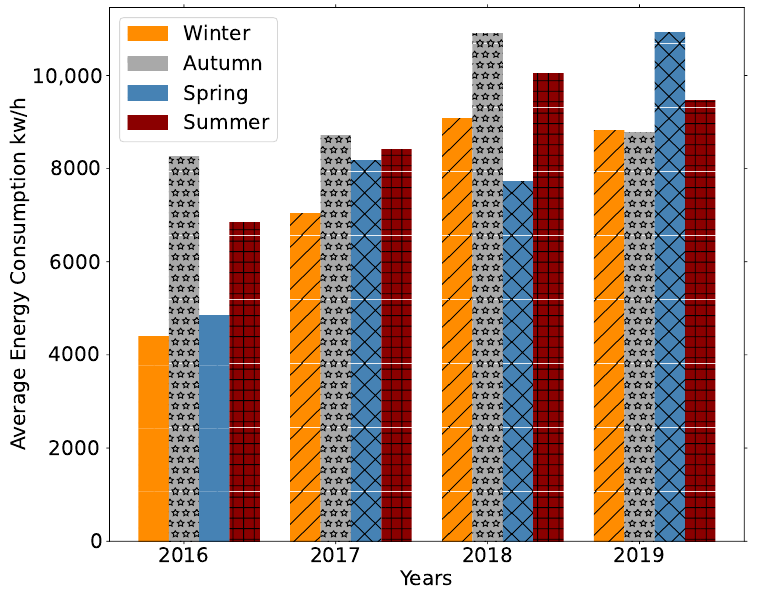
Figure 4. Mean energy consumption per seasons of the year.